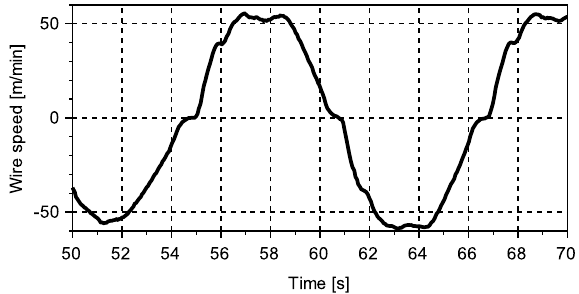
Figure 20: Winch speed profile for Fig.